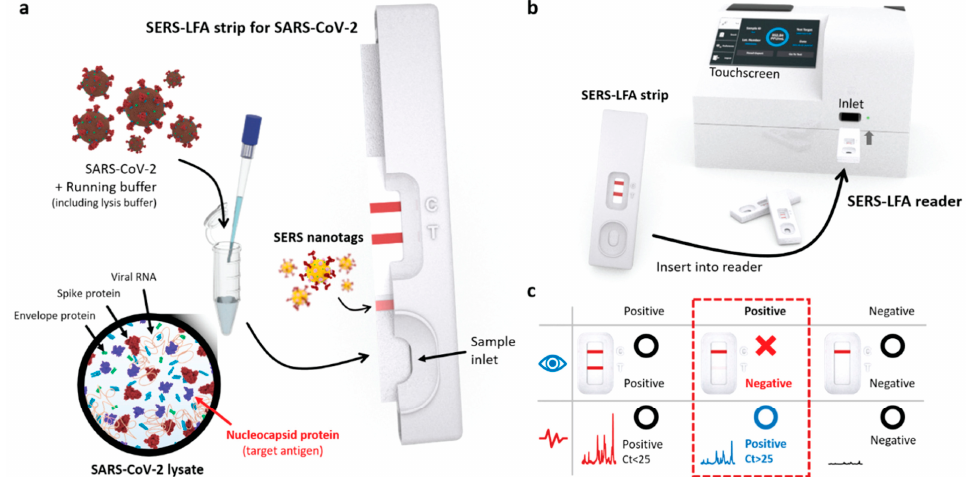
Figure 2. Schematic representation of the SERS-LFA system for the on-site detection of SARS-CoV-2. ( a ) The SERS-LFA strip. ( b ) The portable SERS-LFA reader. ( c ) The advantage of the portable Raman reader-based SERS-LFA system for on-site diagnosis compared to the commercial LFA strip. The red box indicates that most LFA assays showed false-negatives with low virus concentration (Ct > 25 in RT-PCR); however, the SER-LFAs showed positives, owing to their high sensitivity. Reprinted with permission from [37]. Copyright (2022) ACS